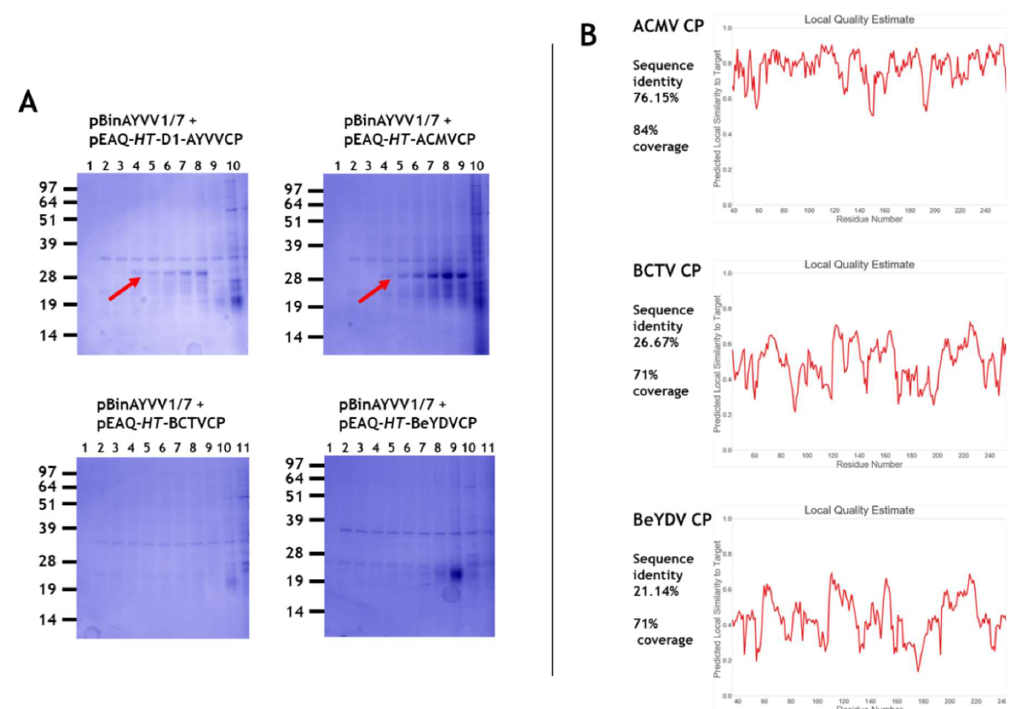
Figure 2. ( A ) An amount of 12% MOPS buffered NuPAGE gels of caesium sulphate gradient fractions. The infiltrated gene constructions for each gradient are indicated above each gel. Fractions are shown from the bottom (1) to the top of the gradient (10 or 11) from left to right. Red arrows indicate the position of coat protein. ( B ) Local quality estimation assessments for the 3-D relatedness of the different coat proteins to the known ageratum yellow vein virus (AYVV) coat protein 3-D structure. Relative sequence identity and structural coverage for each are indicated on the left.